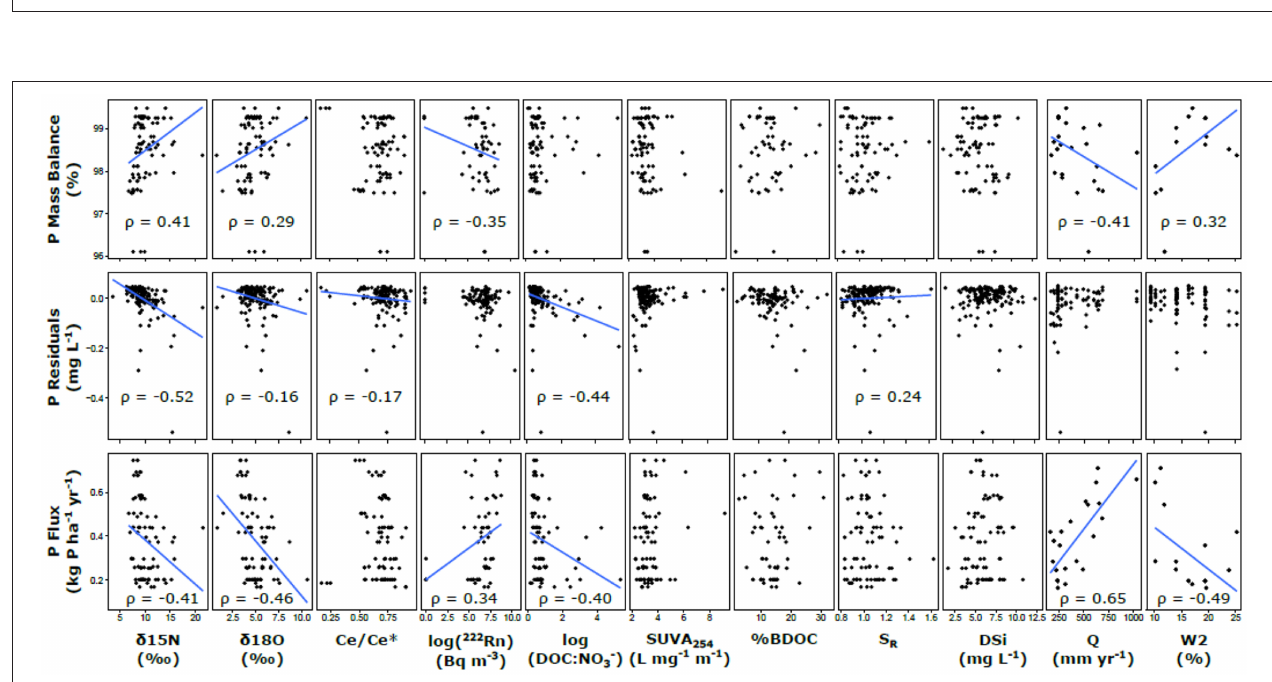
FIGURE 8 | Correlation analysis of P attenuation metrics and proxies. Trend lines are included for significant Spearman correlations ( p < 0.05) to test for potential relationships.